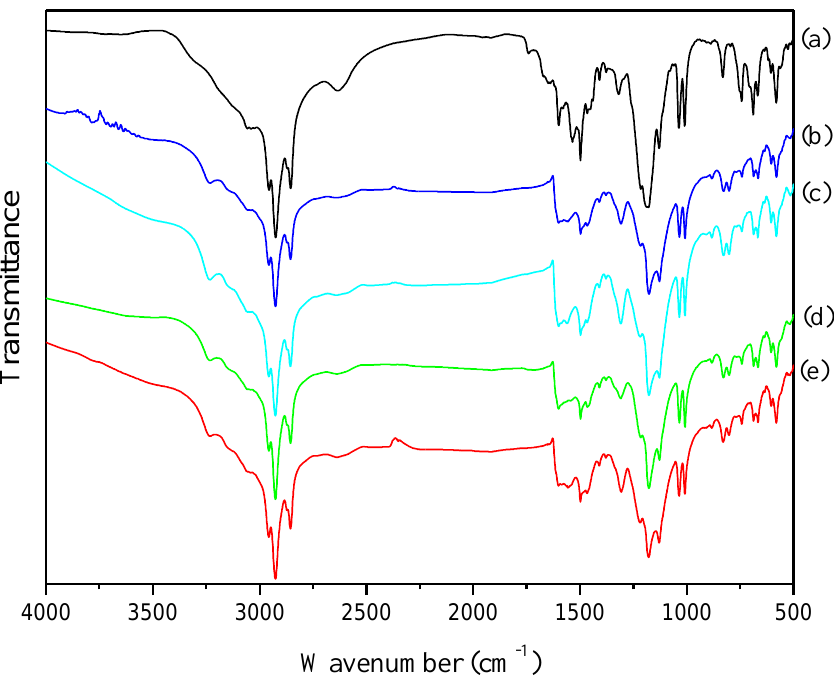
Figure 3. FT-IR spectra of PANDB synthesized in xylene at 25 °C: ( a ) 6 h ; ( b ) 12 h ; ( c ) 24 h ; ( d ) 36 h ; and ( e ) 48 h.